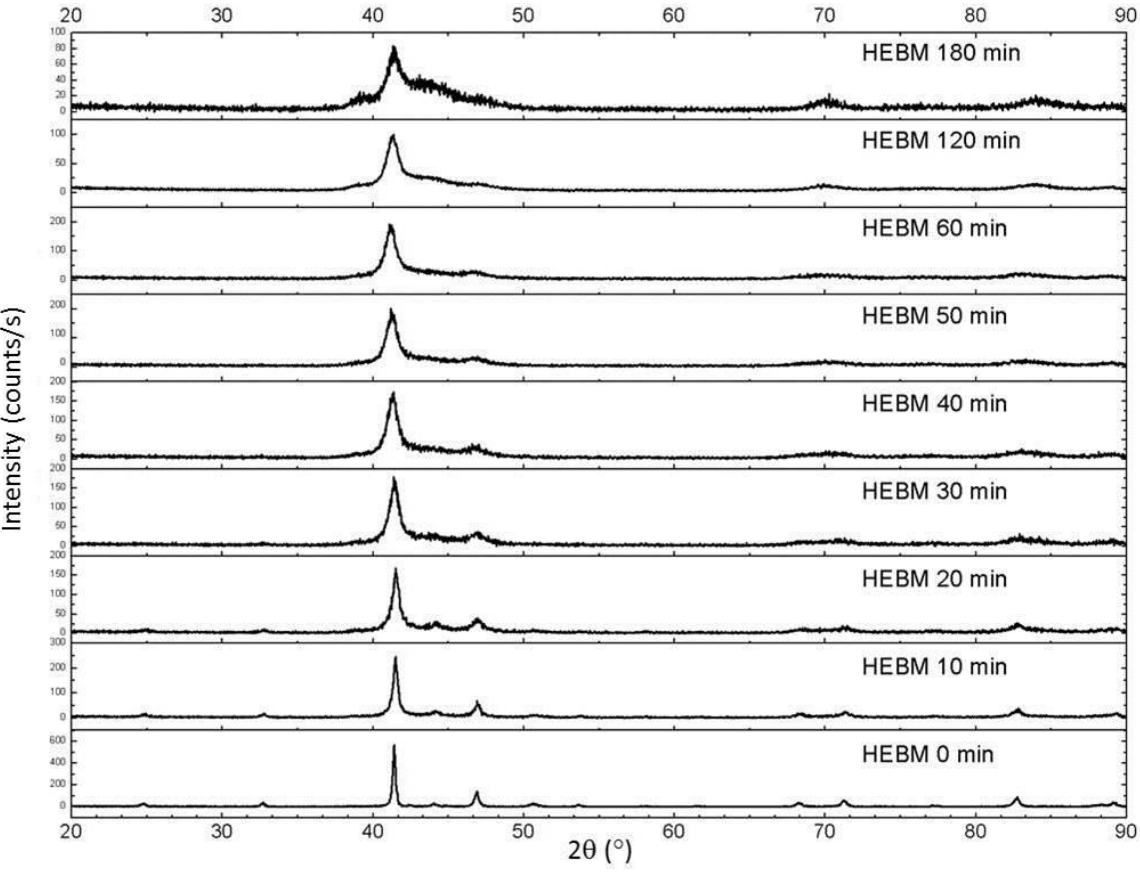
Figure 3. X-ray diffraction patterns for τ-milled samples for different milling (MM) times. The bottom pattern is as-annealed (initial τ phase).